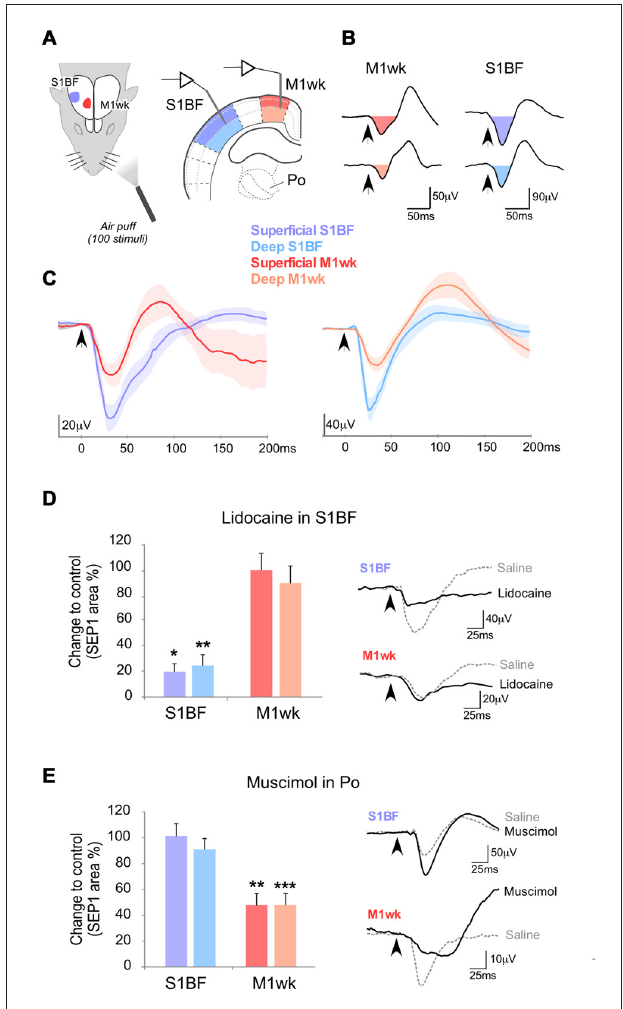
FIGURE 1 | Somatosensory-evoked potentials (SEPs) in M1wk and S1BF cortex by passive multi-whisker stimulation. (A) Diagram of the experimental protocol. Tactile stimulation (air puffs) was applied to the trimmed contralateral whiskers (100 stimuli, 1 Hz) of urethane anesthetized rats, and SEPs were recorded in the S1BF (shaded in blue) and M1wk (shaded in red) cortices. In each area, separate recordings were made in the superficial and deep layers (indicated in shades of color). (B) Representative SEPs recorded in superficial and deep cortical layers. SEPs consist of negative waves that are followed by positive waves. The color-filled areas indicate somatosensory-evoked field potentials (SEP1), the first component of the evoked potential that was compared between experiments. Arrowheads indicate the moment of whisker stimuli application. (C) Overlap of averaged SEP waveforms ( n = 7 in each case) recorded in superficial and deep layers. Lines indicate mean values and lightly-shaded areas indicate standard errors. (D) Effect of S1BF silencing (lidocaine 2% injection, 0.1–0.3 µ l) on cortical responses to whisker stimulation. In this and in the following figures, changes in SEP1 area in S1BF and M1wk are shown as the percentage of differences to control values. Representative examples of SEPs recorded in M1wk and S1BF under lidocaine application in S1BF and control condition are shown on the right. (E) Effect silencing Po with injected muscimol (1 mM, 0.1 µ l) on cortical responses to whisker stimulation. Changes in SEP1 curve areas in S1BF and M1wk are shown as in (D) . Representative examples of SEPs recorded in M1wk and S1BF after muscimol and in the control condition are shown on the right. In this and the following figures bars indicate mean and standard errors, P < 0.05 ( ∗ ); P < 0.01 ( ∗∗ ); P < 0.001 ( ∗∗∗